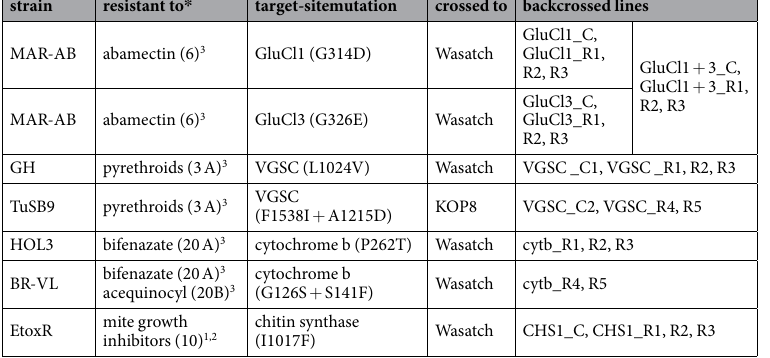
Table 1. Summary of crosses performed to create congenic T. urticae lines. VGSC mutations were numbered according to Musca domestica numbering, whereas GluCl1, GluCl3, cytochrome b and chitin synthase substitutions according to Tetranychus urticae numbering. * IRAC mode of action group number is shown between brackets. Superscript numbers indicate which mite stage was used in the toxicity assay (1: larval toxicity assay, 2: egg toxicity assay, 3: adult toxicity assay). Refer to section Toxicity bioassays for more